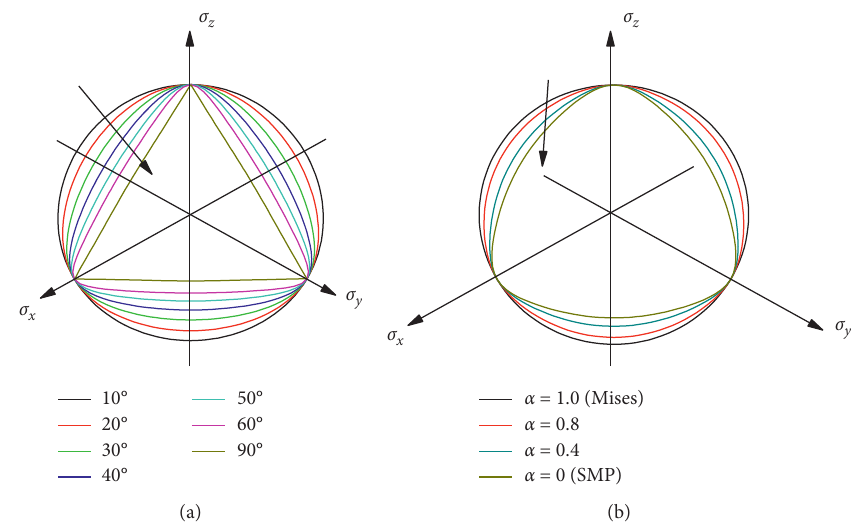
Figure 1: Variations of criterion with φ